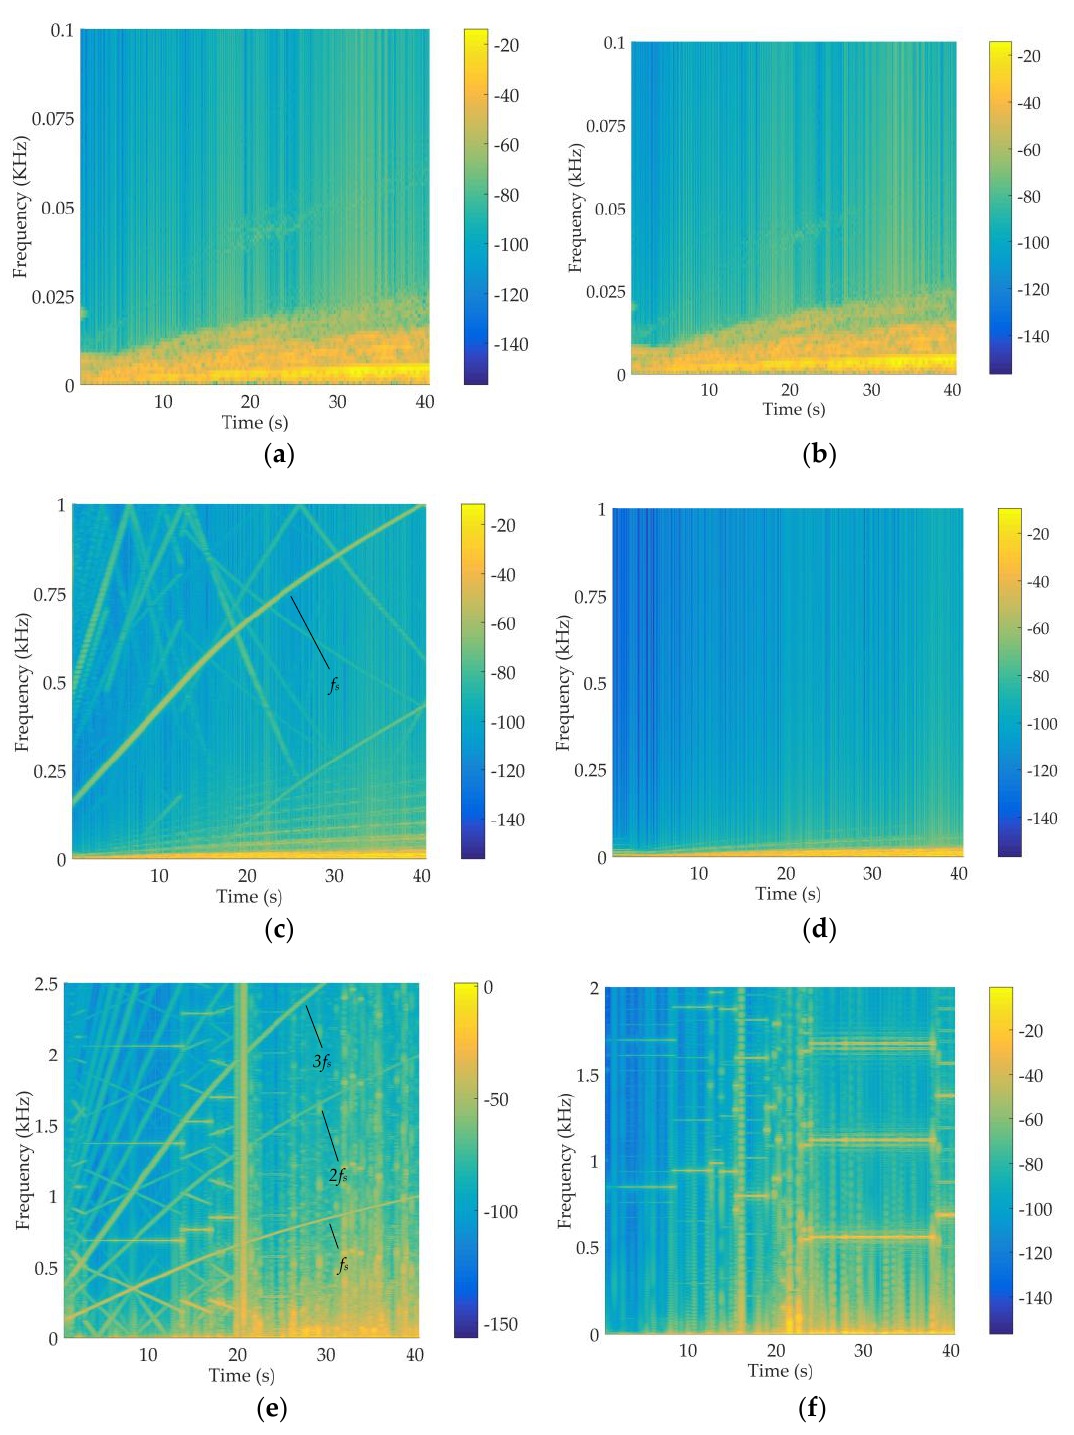
Figure 11. Time – frequency diagram of the vertical vibration acceleration of the motor car and trailer: ( a ) car body of the motor car; ( b ) car body of the trailer; ( c ) bogie frame of the motor car; ( d ) bogie frame of the trailer; ( e ) wheelset of the motor car; and ( f ) wheelset of the trailer.